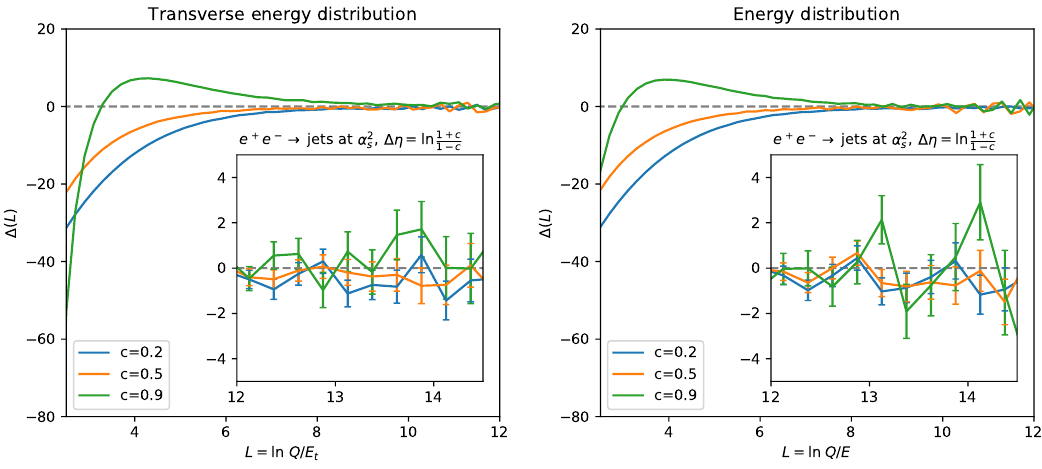
Figure 5 . Fixed order tests against Event2 for transverse energy (left) and energy (right) distri- butions and different widths of the rapidity